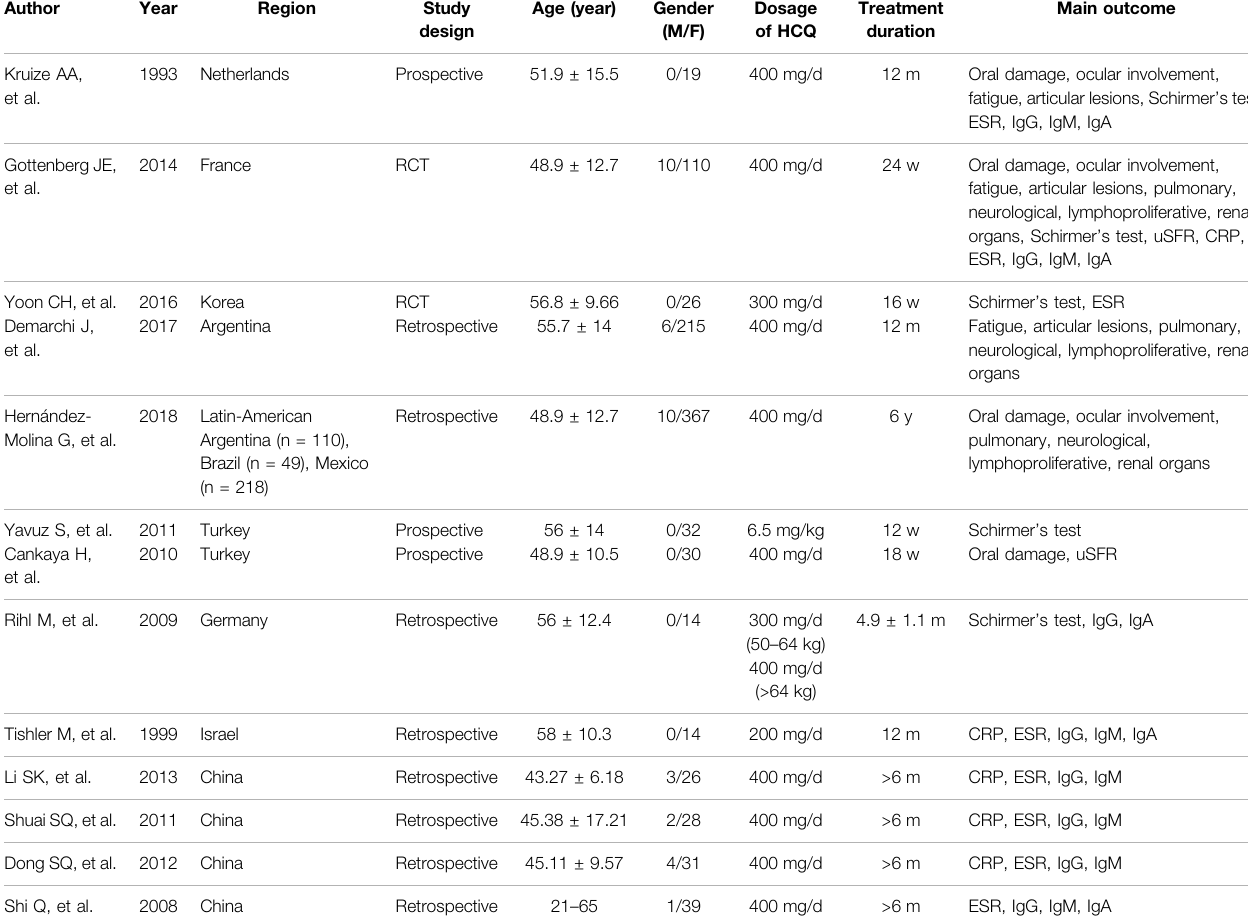
TABLE 1 | Characteristics of included